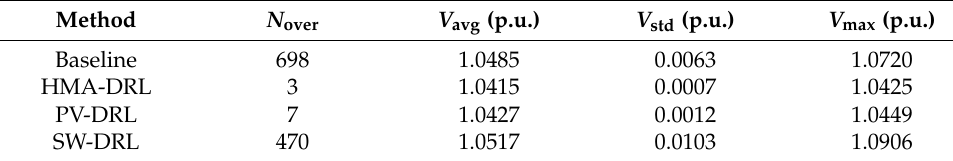
Table 4. Frequency and severity of the overvoltage problems during the test period. Method N over V avg